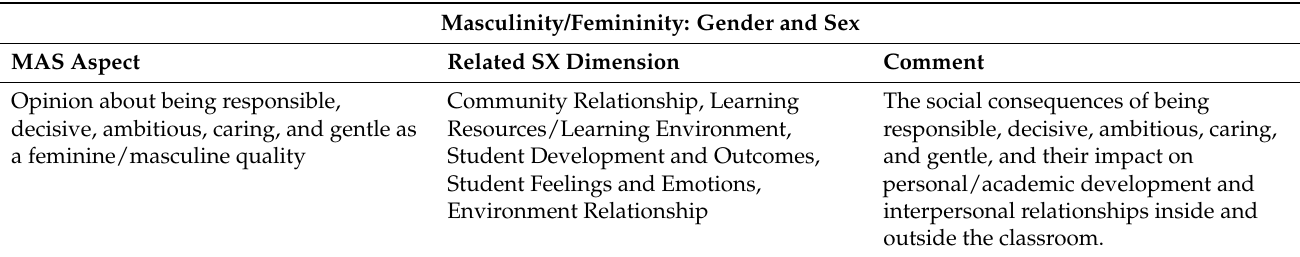
Table 4. Gender and sex in